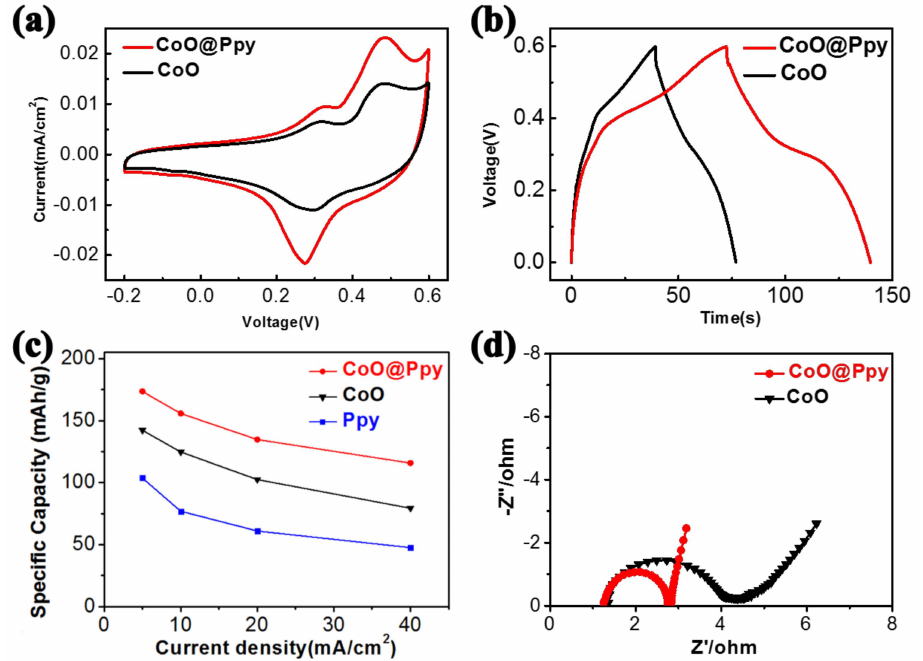
Figure 3. ( a ) CV curves, ( b ) charge-discharge curves, ( c ) rate capability, and ( d ) electrochemical impedance spectroscopy of the CoO nanowires and the core-shell CoO@Ppy